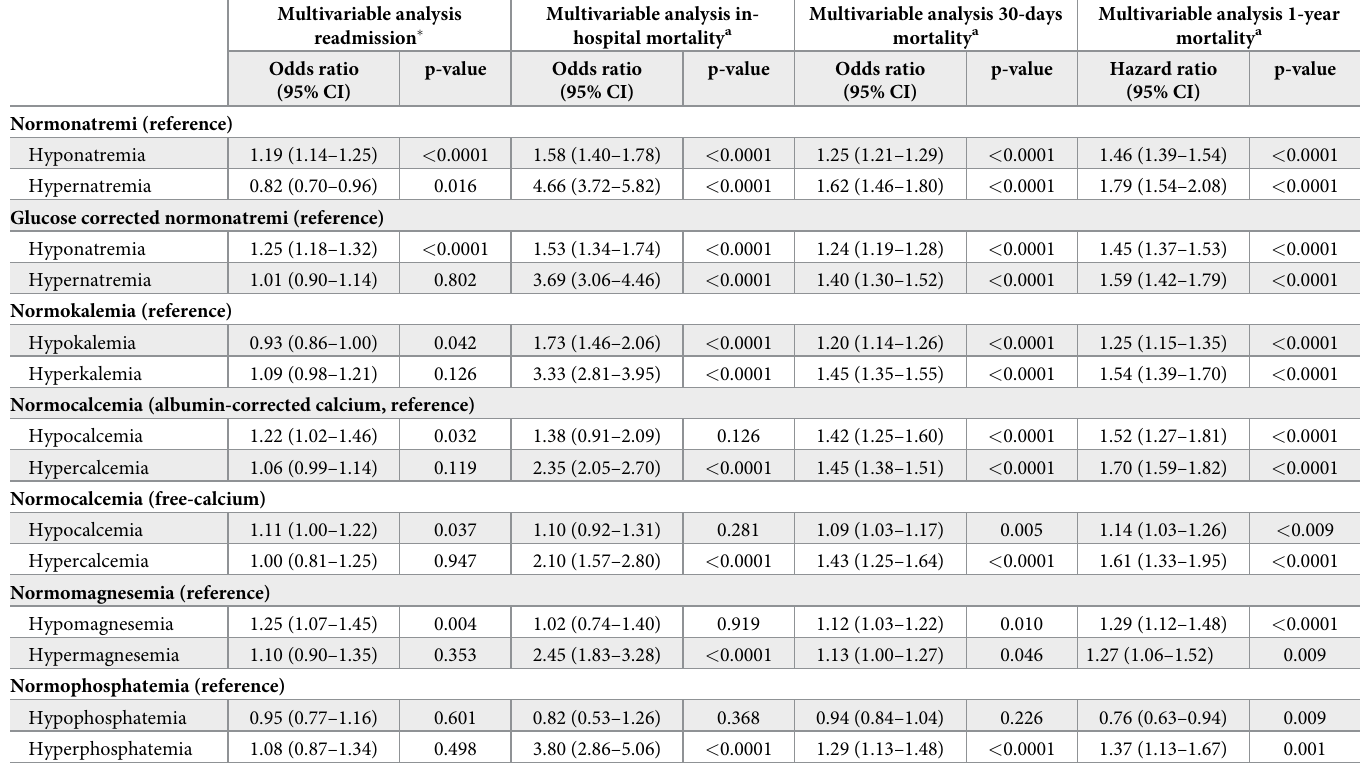
Table 4. Multivariate analysis for readmission, in-hospital, 30-day and 1-year mortality for all ED visits 2010–2015. Multivariable analysis readmission